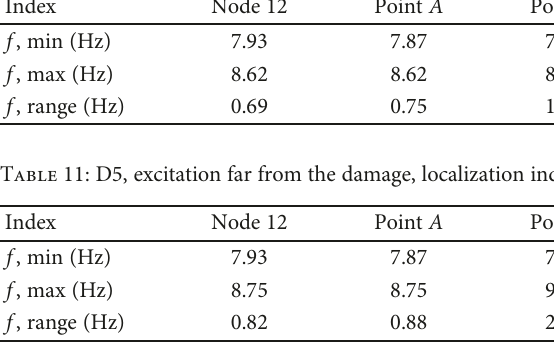
Table 10: D5, excitation near the damage, localization indexes. Index Node 12